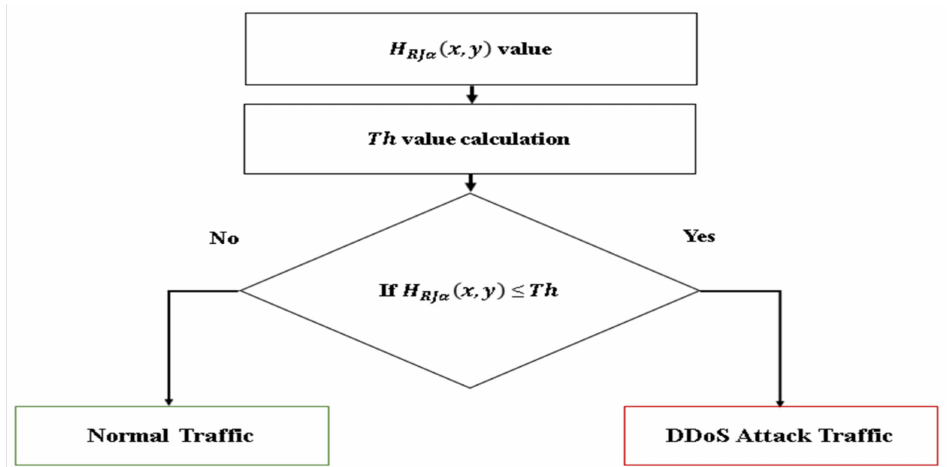
Figure 1. Rule-based DDoS detection